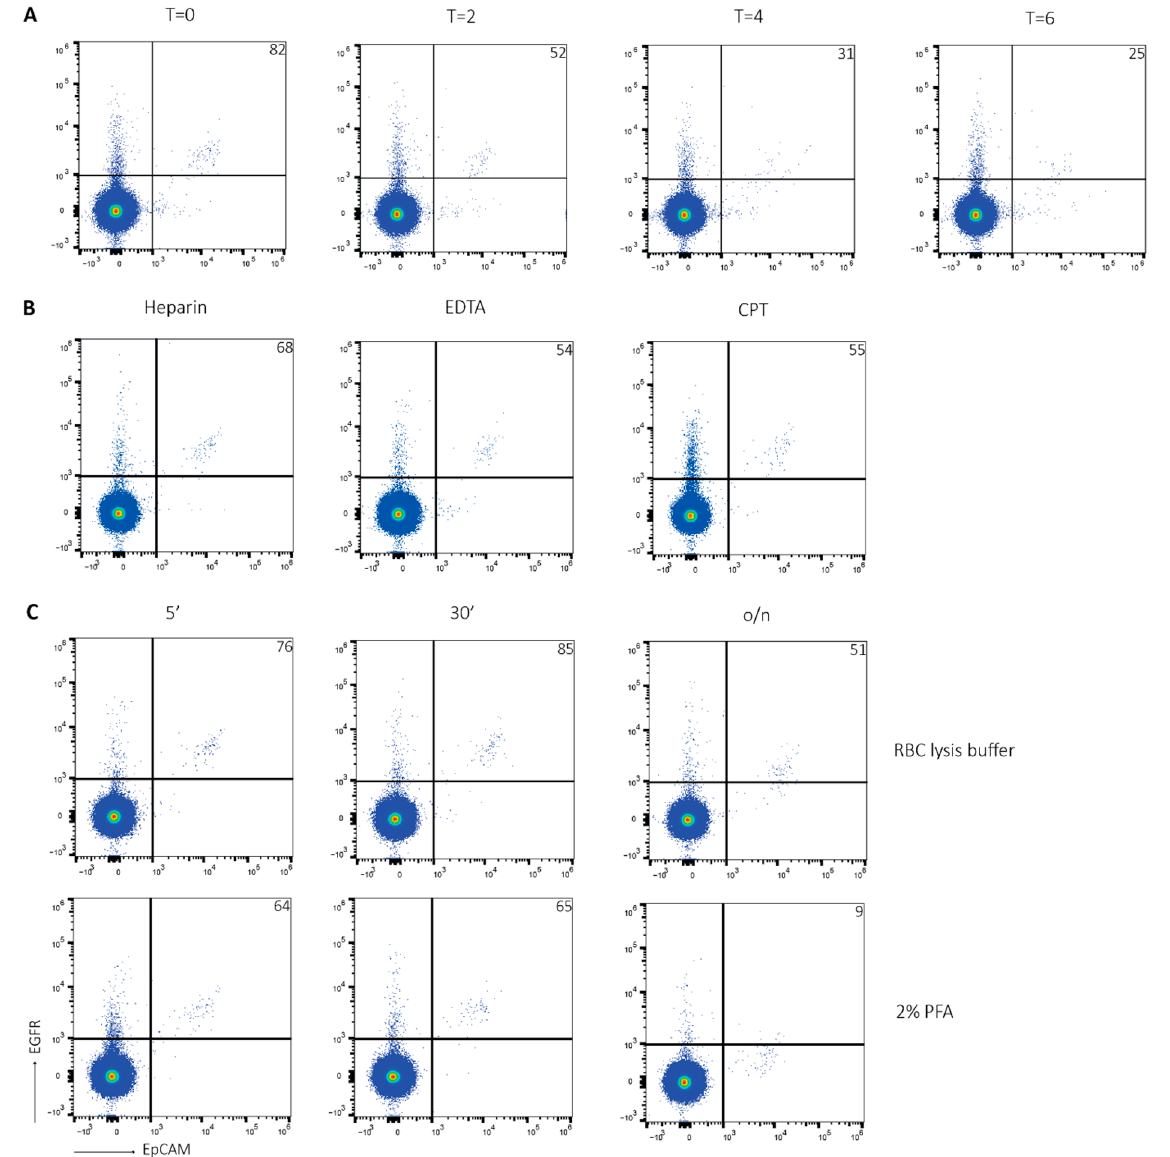
Figure 3. Optimization of CTC detection. ( A ) Healthy donor blood was spiked with 100 HCT116 cells and processed at T = 0 (first column), T = 2 (second column), T = 4 (third column) and T = 6 h after blood collection (fourth column). After PBMC isolation, samples were stained for EpCAM and EGFR, and analyzed using the Attune NxT. Tumor cells were detected by EpCAM+EGFR staining. ( B ) Healthy donor blood was collected in either a heparin tube (left column), an EDTA tube (middle column) or a CPT tube (right column) and spiked with 100 HCT116 cells. After PBMC isolation, samples were stained for EpCAM and EGFR, and analyzed using the Attune NxT. Tumor cells were detected by EpCAM+EGFR staining. Representative figure of N = 3. ( C ) Healthy donor blood was spiked with 100 HCT116 cells. After PBMC isolation, samples were fixated with RBC lysis buffer (upper row) or 2% PFA (lower row) for 5 min (left column), 30 min (middle column) or overnight (right column). Then, samples were stained for EpCAM and EGFR, and analyzed using the Attune NxT. Tumor cells were detected by EpCAM+EGFR staining. Number of detected tumor cells is indicated in upper right corner. Representative figure of N = 5.